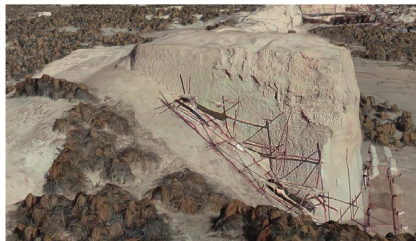
Figure 3: The reinforced wall in Suoyang city: virtual 3D model.